Question: Identify the chart type used in this figure.
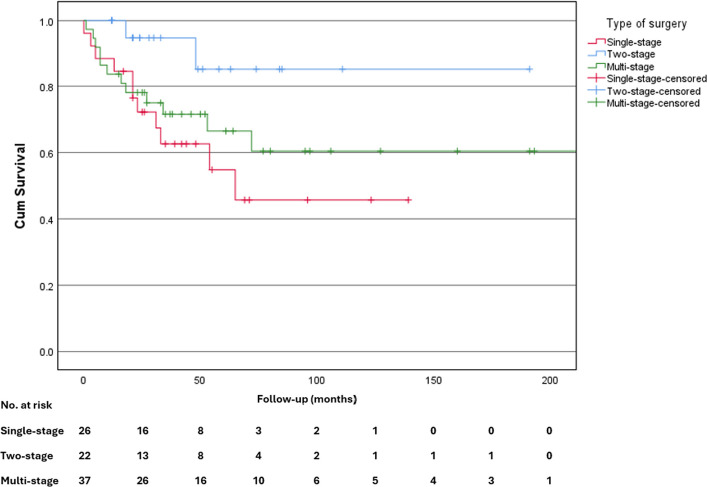
Answer: survival